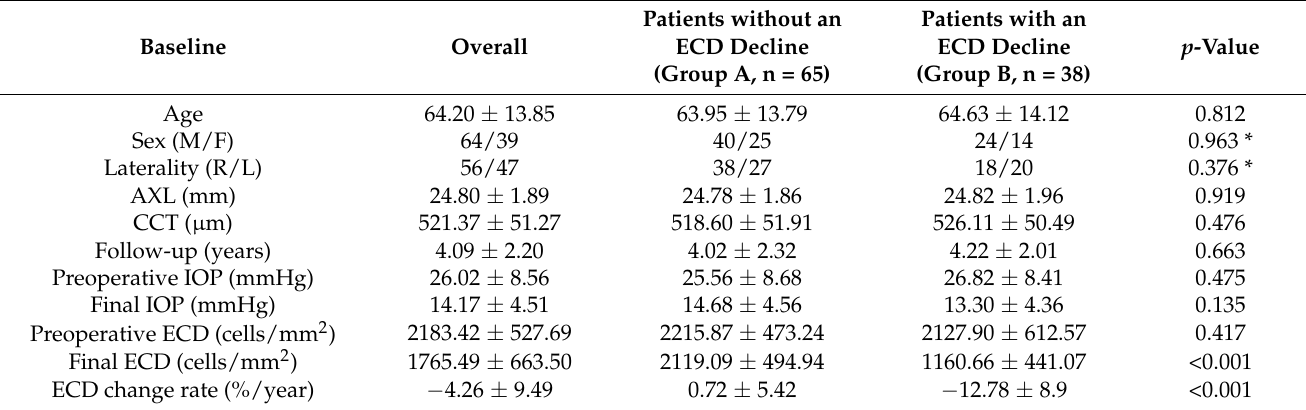
Table 1. Patient medical and demographic characteristics (n =